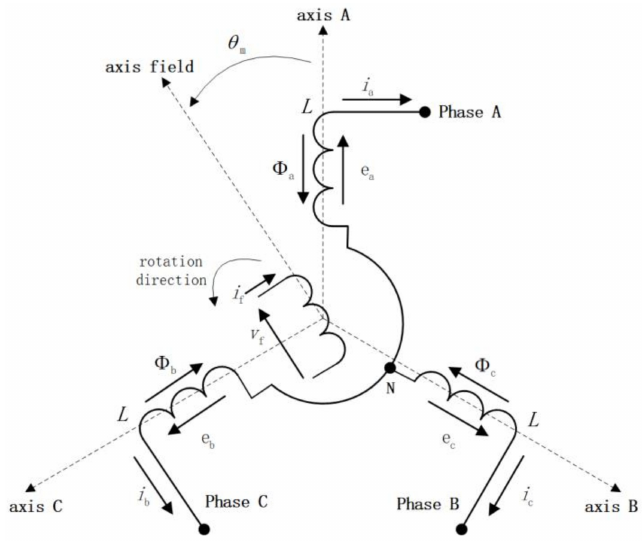
Figure 3. Structure of a two-pole electric